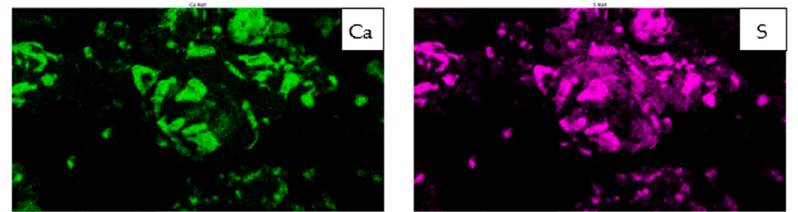
Figure 4. XRD Spectra of petcoke ashed at 750 °C.